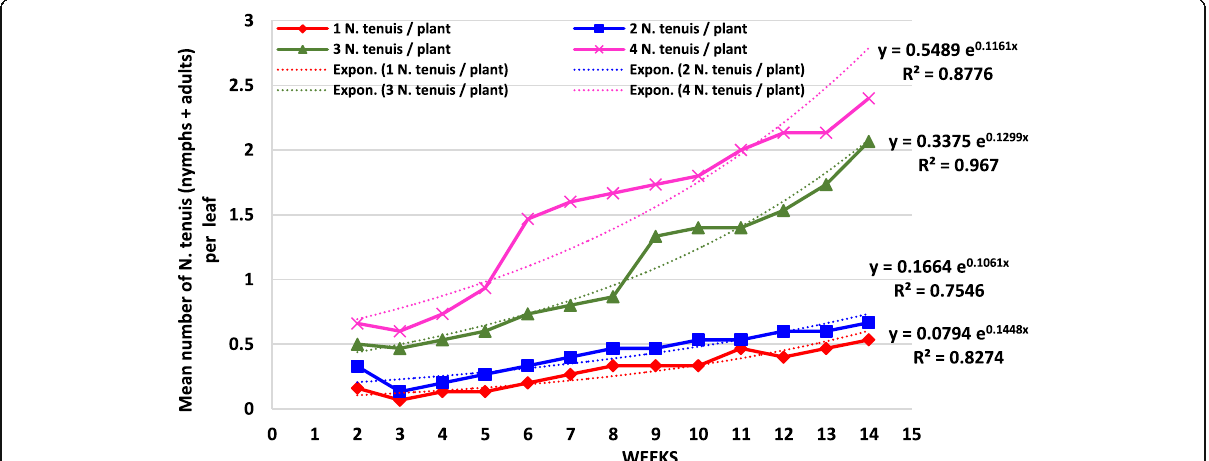
Fig. 2 Mean number of Nesidiocoris tenuis (nymphs + adults) per leaf and exponential analysis of the mean as a function of treatment concentrations with (1, 2, 3, and 4) predator nymphs per plant for 14